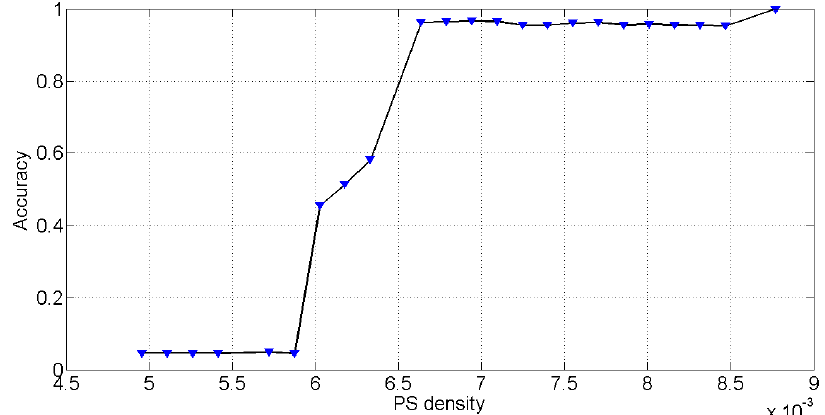
Figure 4. Accuracy of proposed approach against different PS